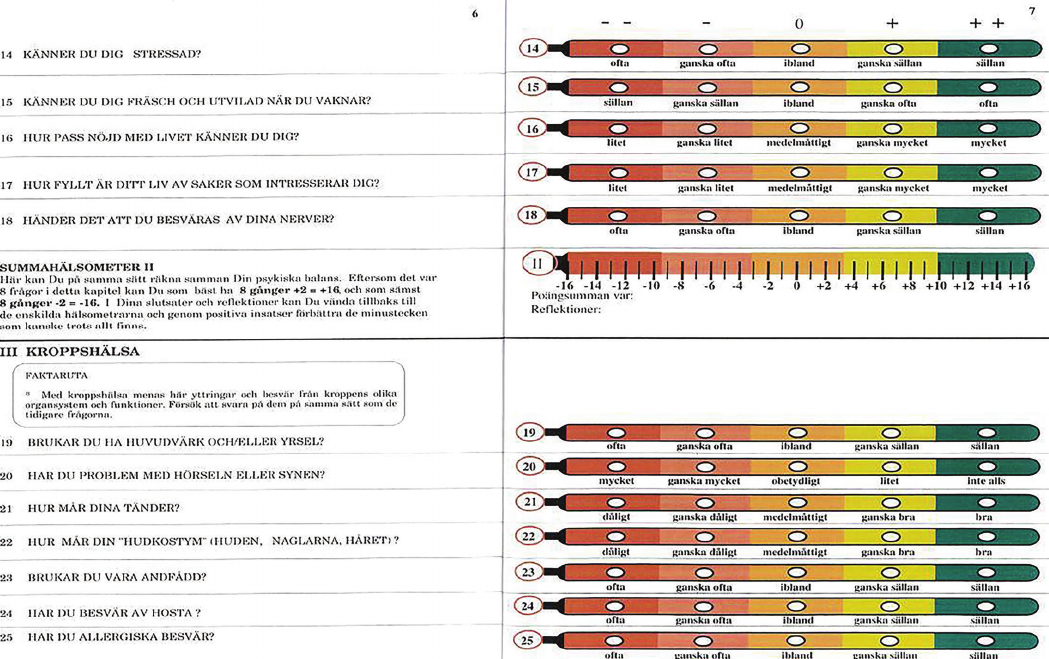
Figure 1: In Swedish. A page from short screening questionnaire used in the ¨Osterg¨otland county population health policy program [5] with concluding part of mental health chapter and its summing-up scale and start of physical health chapter with its short introductory fact box. The largely self-explanatory summing-up method is to detract the amount of minus signs from and add the amount of plus signs to the grand total. In interactive computer and app versions this can be continuously supported and reinforced including interpretation, conclusions, and